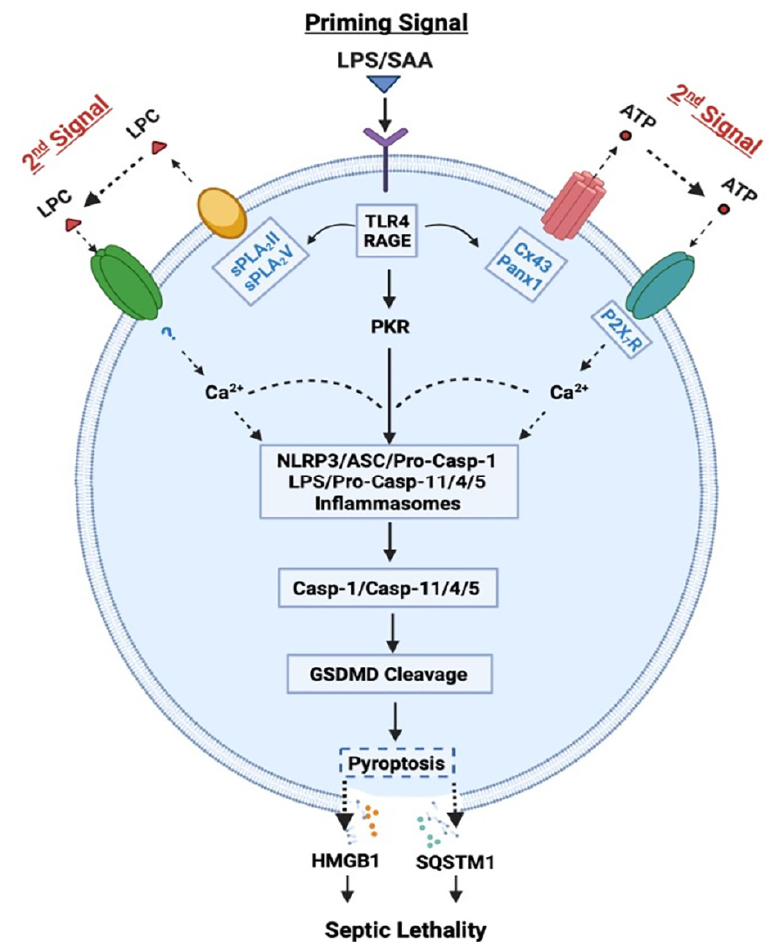
Figure 1. Role of Casp-1-mediated canonical and Casp-11/4/5-mediated non-canonical inflam- masome activation in LPS- or SAA-induced pyroptosis and HMGB1 release. LPS or SAA may prime innate immune cells to up-regulate the expression of Cx43/Panx1 hemichannels, sPLA 2 s and interferon-induced double-stranded RNA-activated protein kinase (PKR), thereby eliciting the release of ATP or LPC that may activate P2X 7 R- or other receptor-mediated Ca 2+ signaling. It then induces a feed-forwarding activation of PKR and inflammasome, cleavage of GSDMD, pyroptosis, and subsequent release of late mediators (such as HMGB1 and SQSTM1) of lethal infections. In contrast, the “canonical” inflammasome activation is characterized by the oligomer- ization of intracellular “nucleotide-binding oligomerization domain (NOD)-like receptors” (NLRs such as NLRP1, NLRP3, and NLRC4) and the “apoptosis-associated speck-like protein containing a C-terminal caspase recruitment domain” (ASC) adaptor, as well